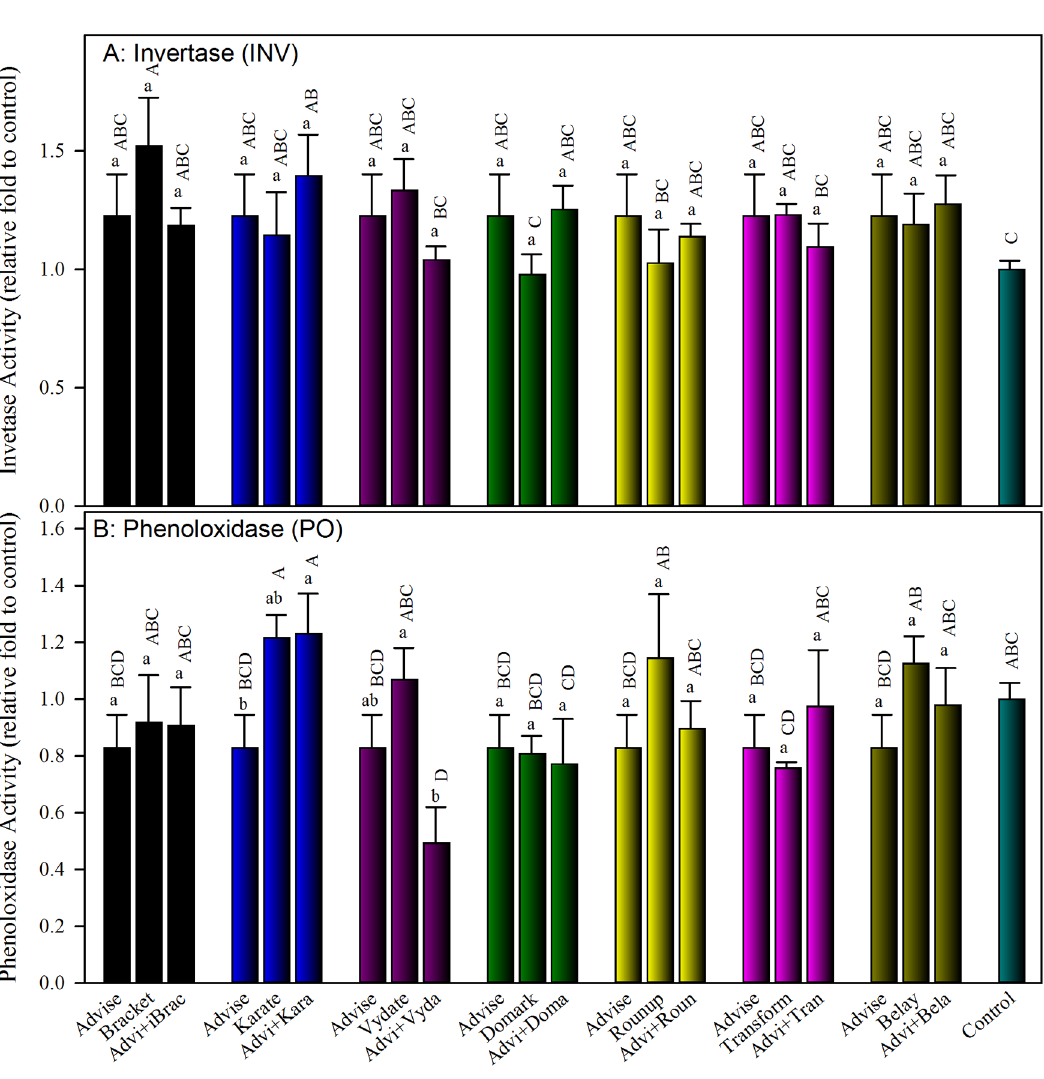
Fig 3. Impact of Advise and binary mixtures with seven representative pesticides on two non-pesticide- interacting enzyme, invertase(A) and phenoloxidase (B), activities in honey bee survivors after spray treatments. All concentrations used are listed in Table 1 as LC 20 determined in a previous study [30]. Advi, Brac, Kara, Vyda, Doma, Roun, Tran, and Bela were used as abbreviationsfor the same order of eight pesticideslisted in Table 1. Same letters abovethe error bars indicate no significantdifference: lower case letters are for within-groupcomparisons; capital letters refer to comparisons among all treatments. The enzyme activity from Advise only was reused in each group for within- group comparisonand